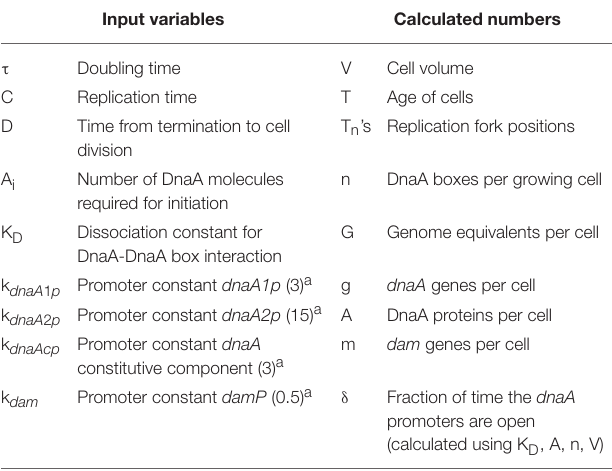
TABLE 2 | Selected parameters used in the Initiator Titration Model.